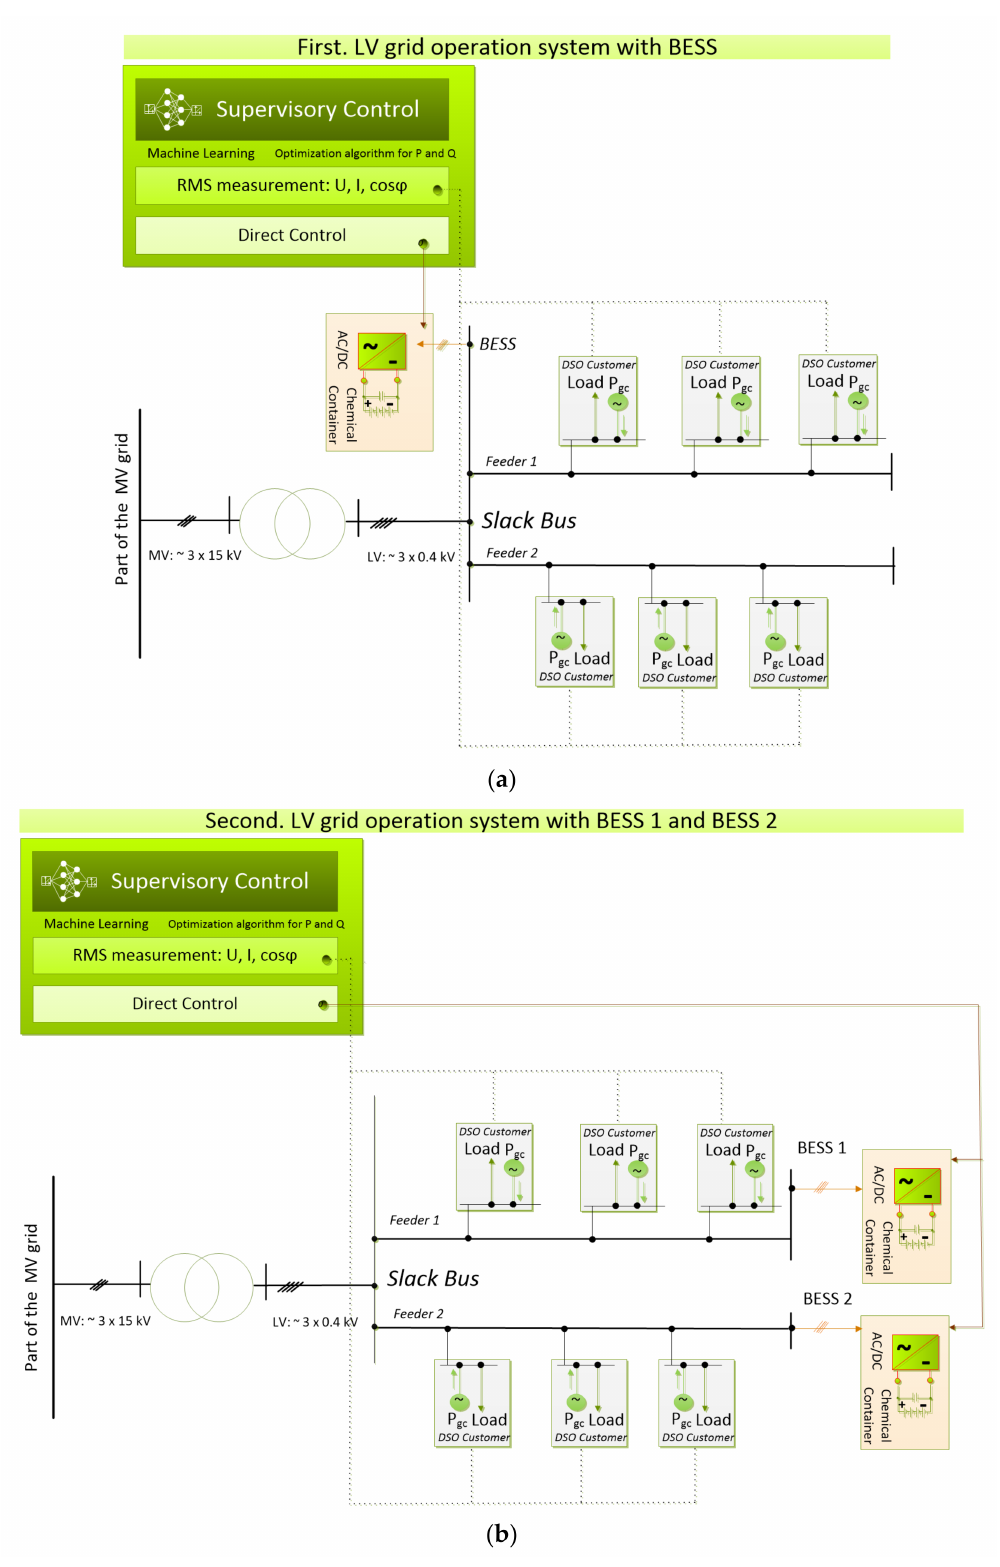
Figure 2. Two hybrid systems for LV grid operation with BESS: ( a ) centralised, ( b ) deep in the LV